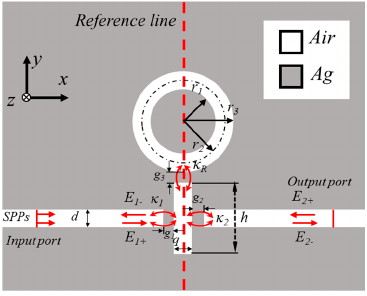
Figure 1. 2D schematic of the metal–insulator–metal (MIM) waveguides coupled with rectangular and ring resonators. SPPs: surface plasmon polaritons. ring resonators. SPPs: surface plasmon